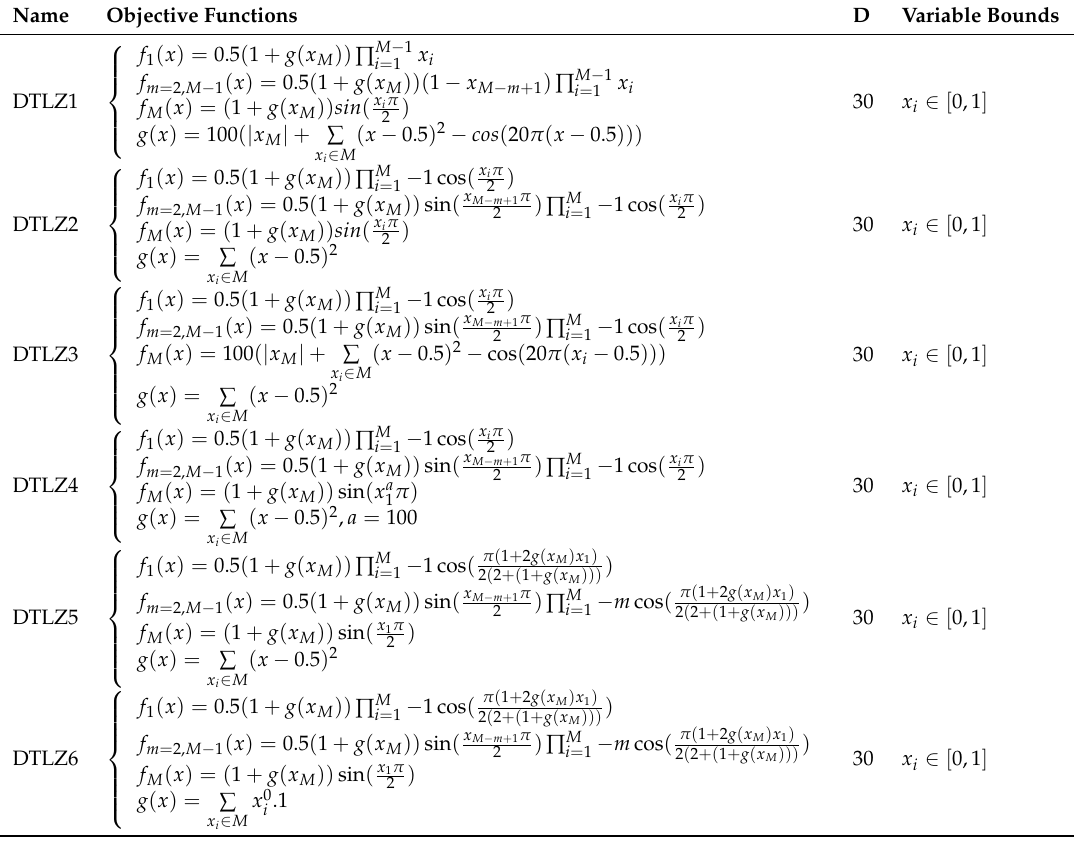
Table 3. Benchmark